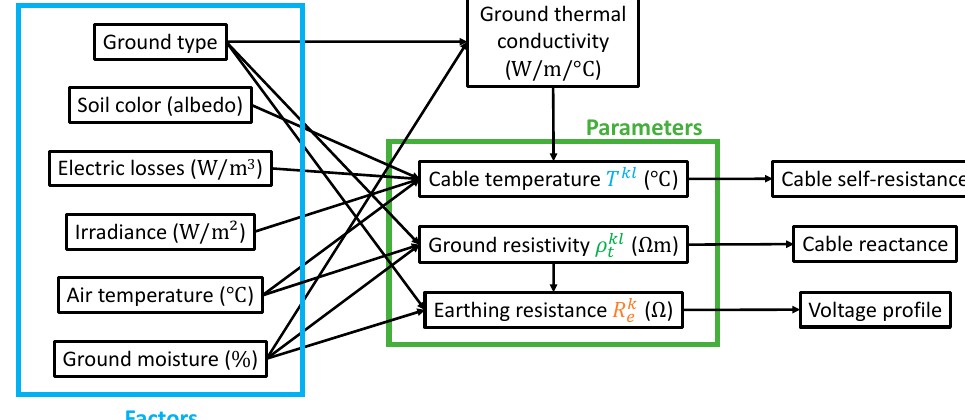
Figure 7. The link between factors, parameters, matrix terms, and voltage profile. External factors have an impact on the external parameters, modifying either the terms of the matrix or the voltage profile.